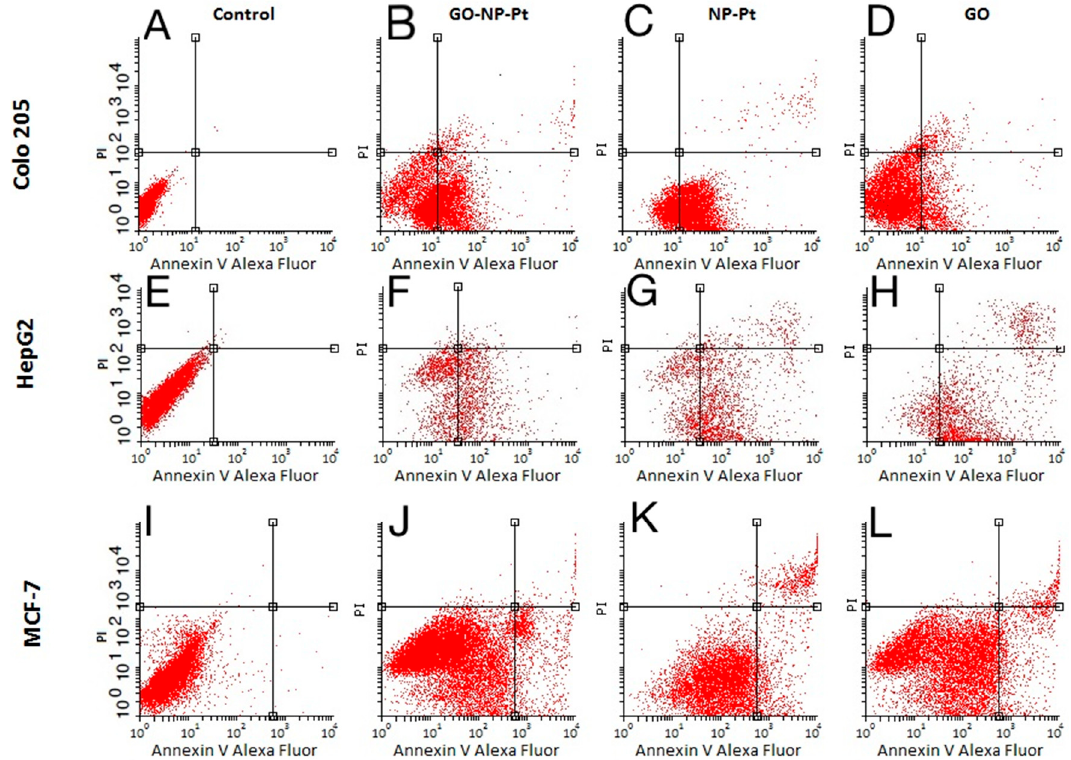
Figure 8. Apoptosis assay. Flow cytometry Annexin V-Alexa Fluor® 488/propidium iodide (PI)